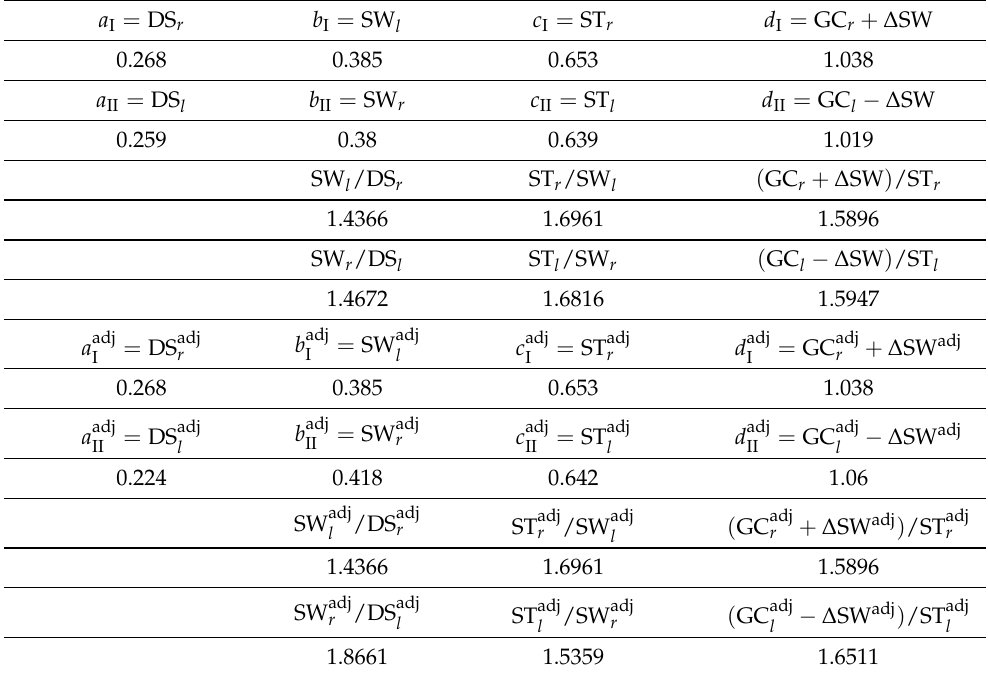
Table 1. Experimental data concerning the elements (in seconds) of the sequences I and II in (3) and their adjoint versions I adj , II adj in (4) for the AT patient A ([DS x = 0.133 s, DS y = 0.135